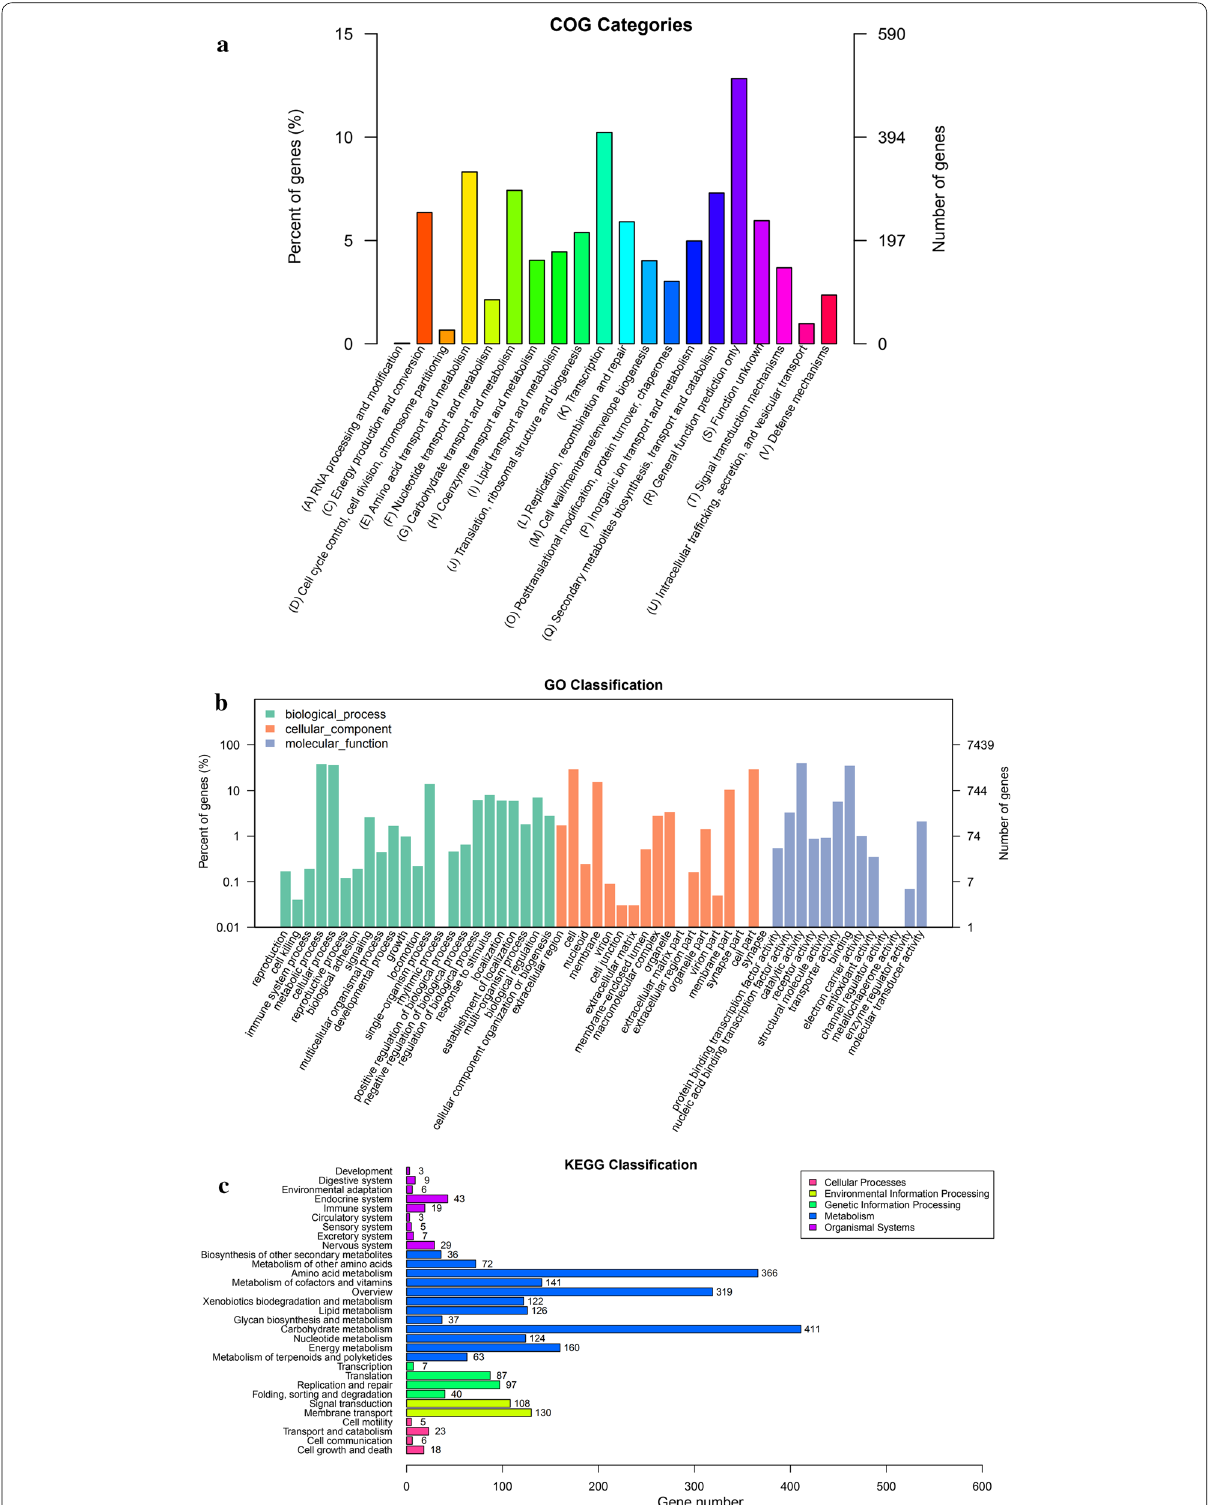
Fig. 3 a COG annotation distribution histogram; b GO annotation distribution histogram; c KEGG pathway classification